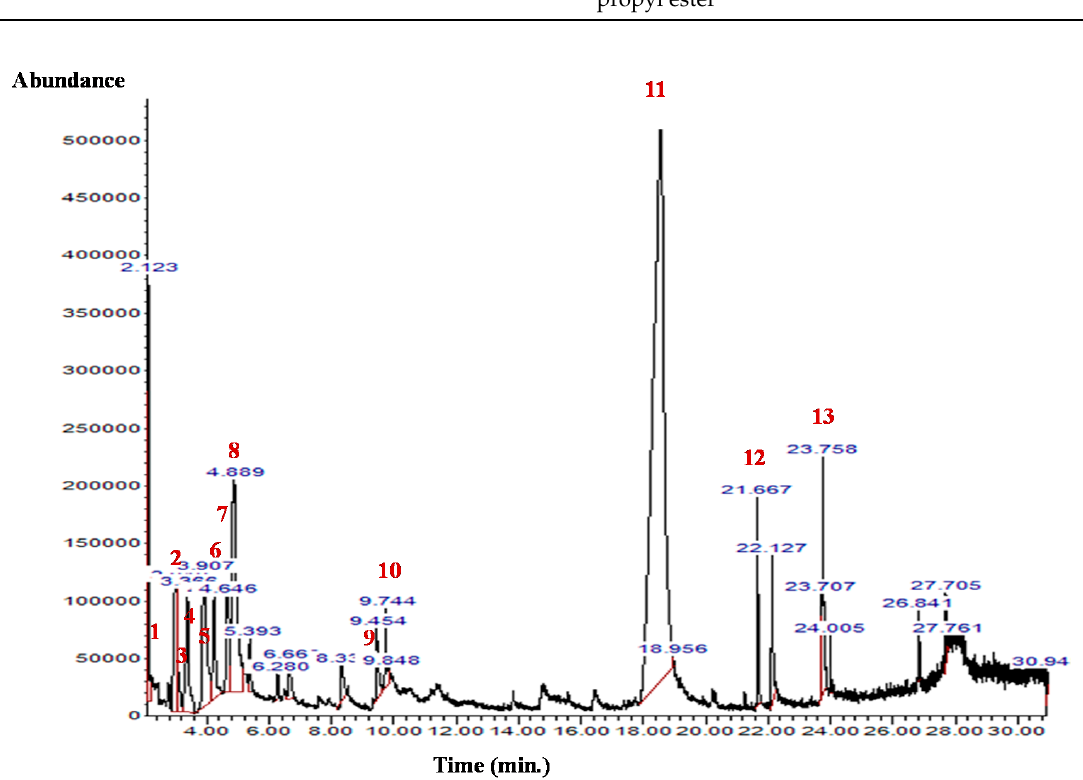
Figure 1. GC-MS chromatogram of the B . aegyptiaca fruit aqueous extract. 1: Hydrazine,